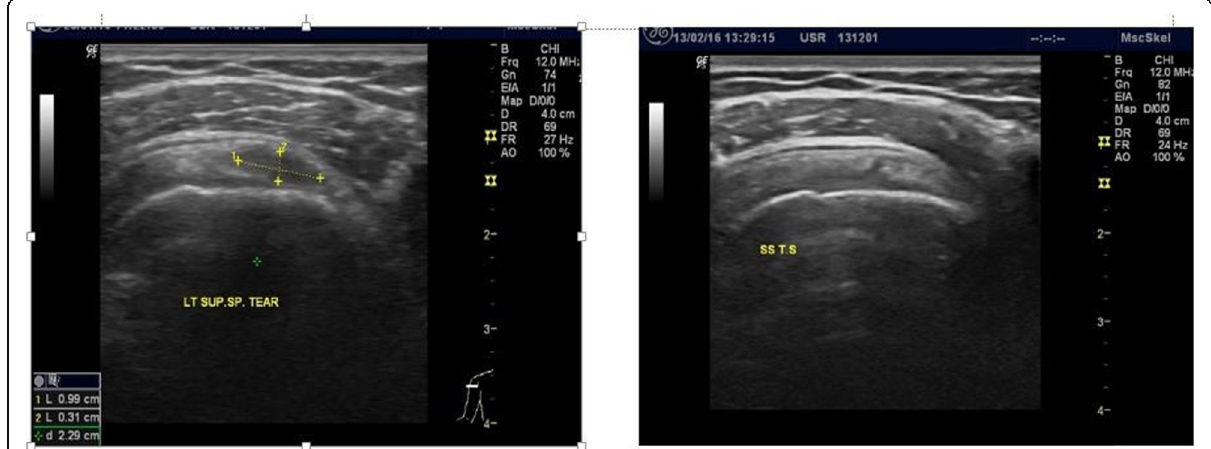
Fig. 2 Ultrasound views on left supraspinatus muscle in patient no. 5. Left panel revealed a G3 tear measured 0.99 × 0.31 cm (yellow lines). Before PRP injection while right panel revealed improvement in tear to GI after PRP injection in the same patient